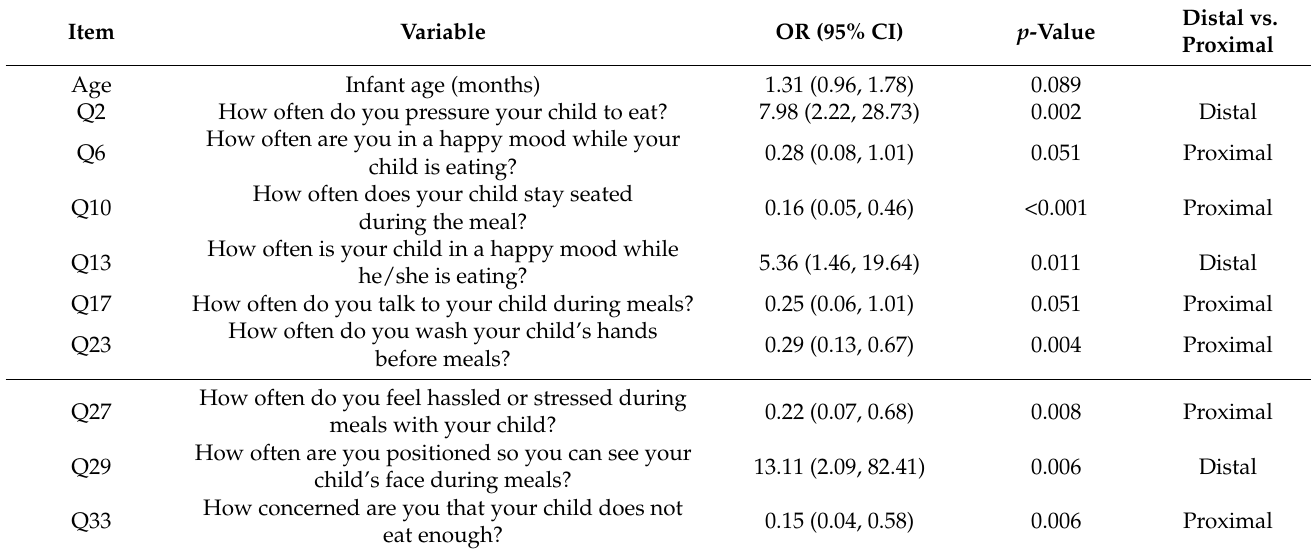
Table 3. Logistic Regression Model Predicting Distal Responsivity.